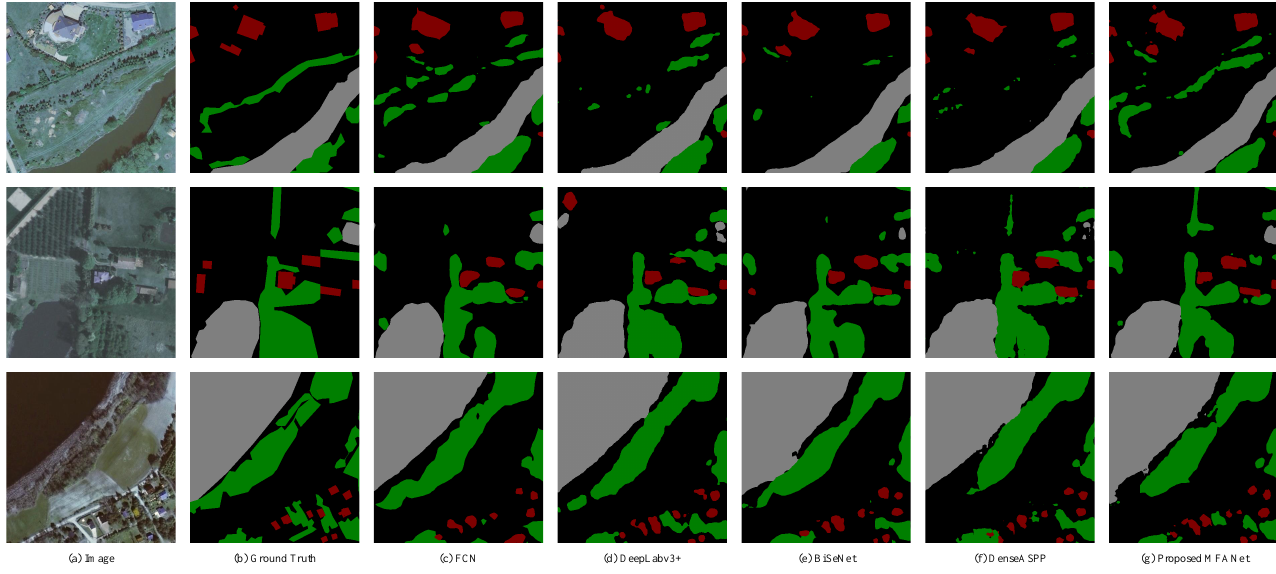
Figure 8. Prediction results of images with four classifications. ( a ) The original images; ( b ) Corresponding labels; ( c ) The predicted maps of FCN; ( d ) The predicted maps of DeepLabv3+; ( e ) The predicted maps of BiSeNet; ( f ) The predicted maps of DenseASPP; ( g ) The predicted maps of proposed